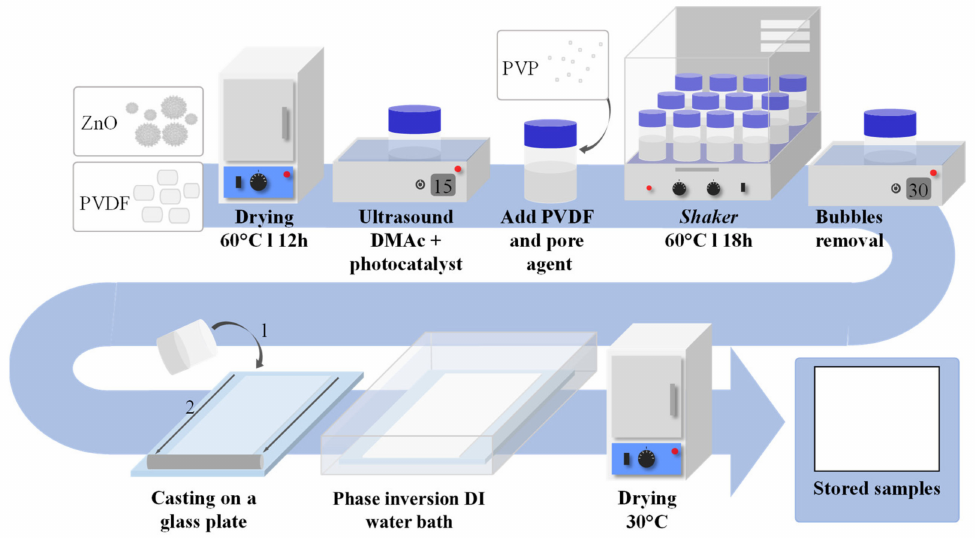
Figure 1. Polymeric composite films preparation